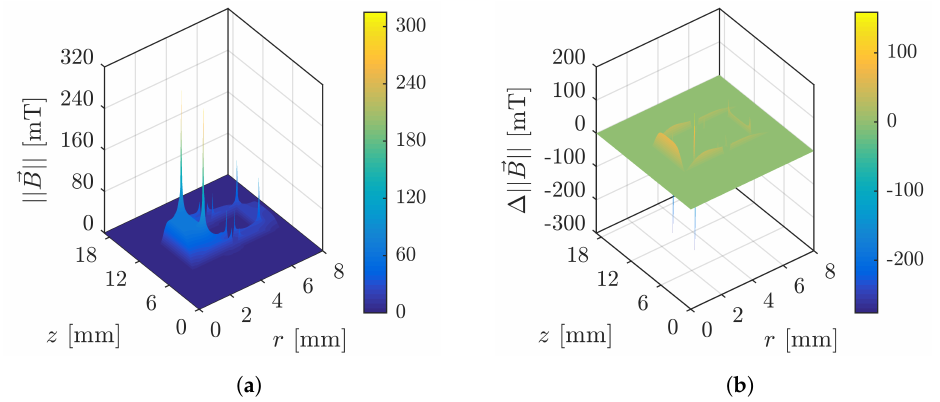
Figure 6. Magnitude of the magnetic flux density ( a ) obtained with the SEM. The difference with respect to the FEM solution is shown in ( b ). Table 2. Post-processing quantities obtained with both the FEM and the SEM, including the absolute value of the relative discrepancy.